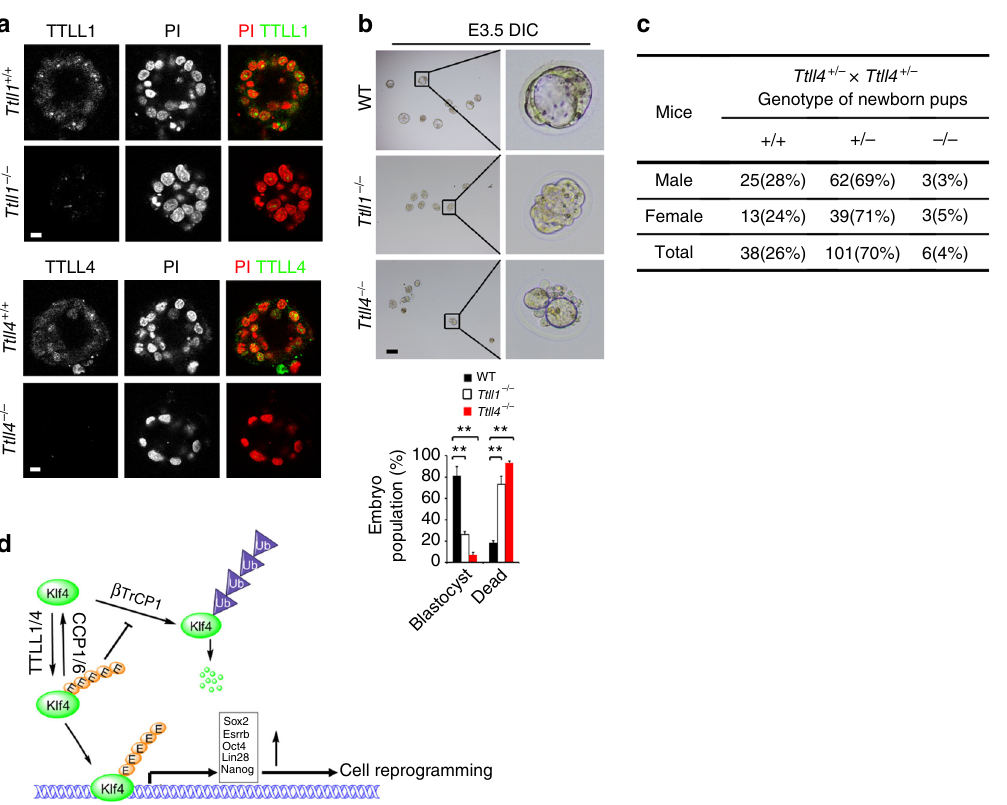
Fig. 8 Deletion of TTLL1 and TTLL4 impairs embryonic development. a TTLL1 and TTLL4 de fi ciency in blastomere was con fi rmed by immuno fl uorescence staining. Scale bar, 20 μ m. b Fertilized eggs were isolated from WT, Ttll1 − / − , and Ttll4 − / − pregnant mice and assessed as in Fig. 1f. Distribution of embryonic stage at E3.5 was counted as means ± S.D (right panel), ** P < 0.01. Scale bar, 100 μ m. For WT embryos, n = 115. For Ttll1 − / − embryos, n = 101. For Ttll4 − / − embryos, n = 108. c Ttll4 -de fi cient pups were genotyped after heterozygotes crossing. Student ’ s t test was used as statistical analysis. Data are representative of four independent experiments. d A working model represents Klf4 polyglutamylation in the regulation of cell reprogramming and early embryogenesis. During the process of reprogramming and pluripotency maintenance, the core pluripotency factor Klf4 is polyglutamylated by TTLL4 or TTLL1 that impedes its K48-linked ubiquitination to maintain Klf4 stability. Deletion of TTLL4 or TTLL1 impairs cell reprogramming and